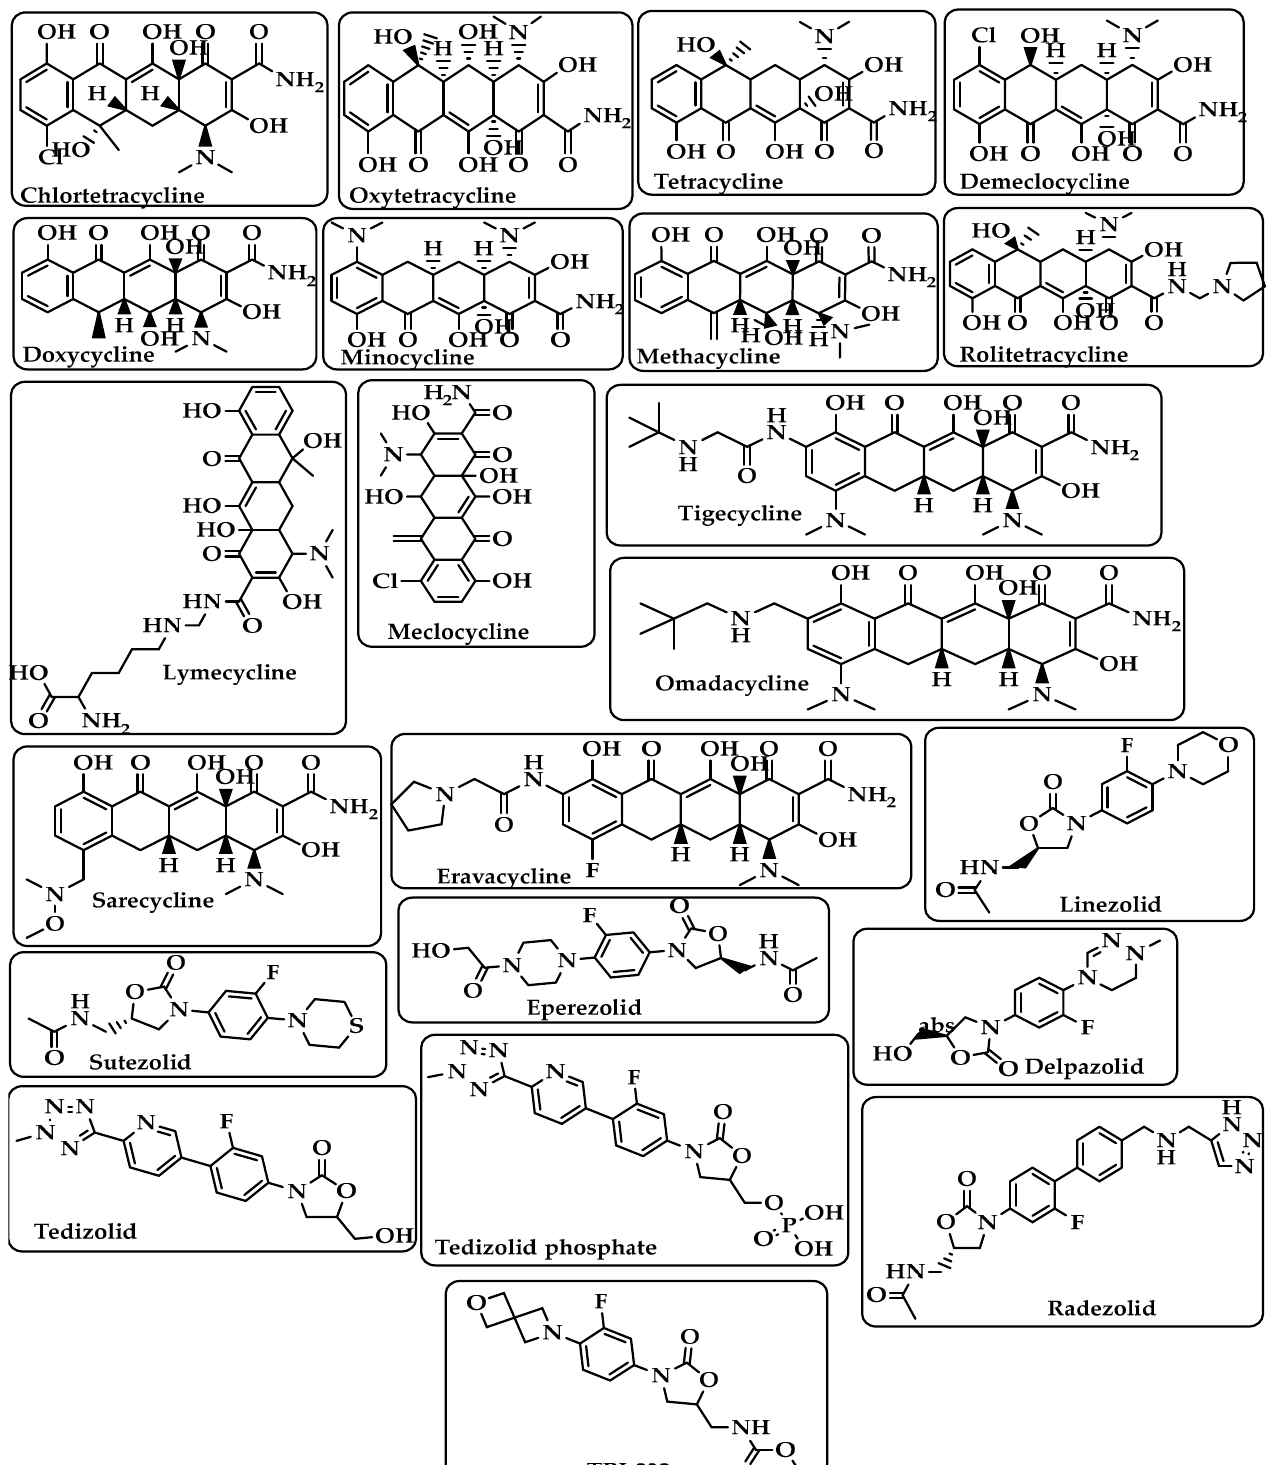
Figure 5. Chemical structure of chlortetracycline, oxytetracycline, tetracycline, demeclocycline, doxycycline, minocycline, lymecycline, meclocycline, methacycline, rolitetracycline, tigecycline, omadacycline, sarecycline, eravacycline, linezolid, sutezolid, eperezolid, delpazolid, tedizolid, tedizolid phosphate, radezolid, and TBI-223.